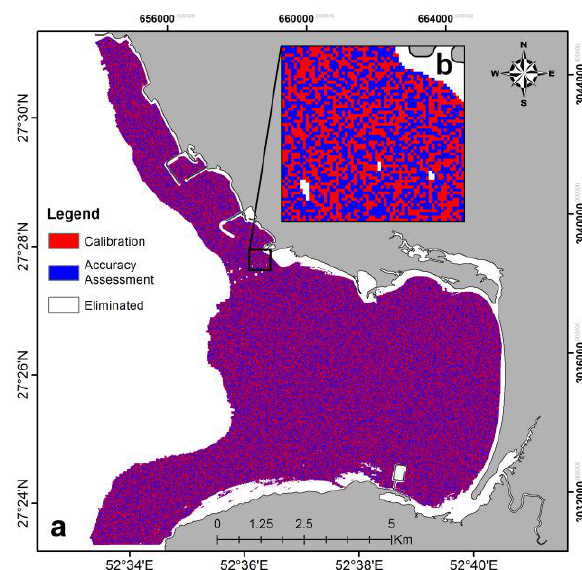
Figure 4. Randomly selected pixels for calibration of the models (blue pixels) and validation of the results (red pixels). The white pixels indicate very shallow coastal areas, clouds or other non- desired points that have been eliminated from computations In the following, the multiple linear regression model was used to determine unknown